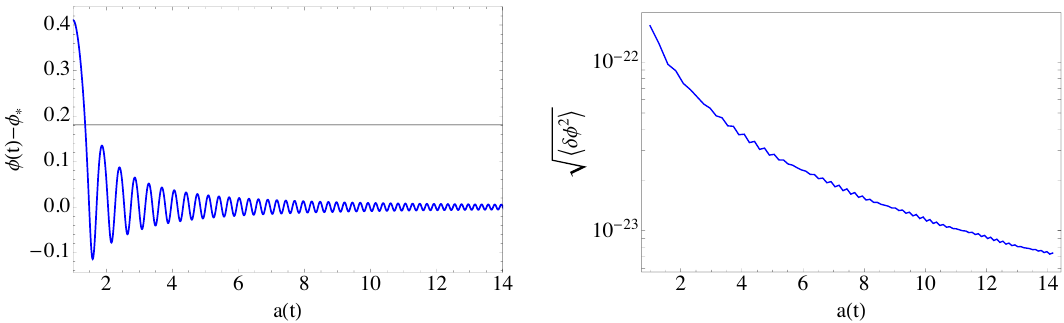
Figure 19 . Numerical results from the evolution of the volume modulus in the LVS. Left: the evolution of (cid:30) ( t ) as a function of the scale factor a ( t ). The solid black line denotes the (cid:12)eld value at the in(cid:13)ection point of the potential. One can see that no tachyonic oscillations occur. Right: p h (cid:14)(cid:30) 2 i as a function of a ( t ). evolution of the variance